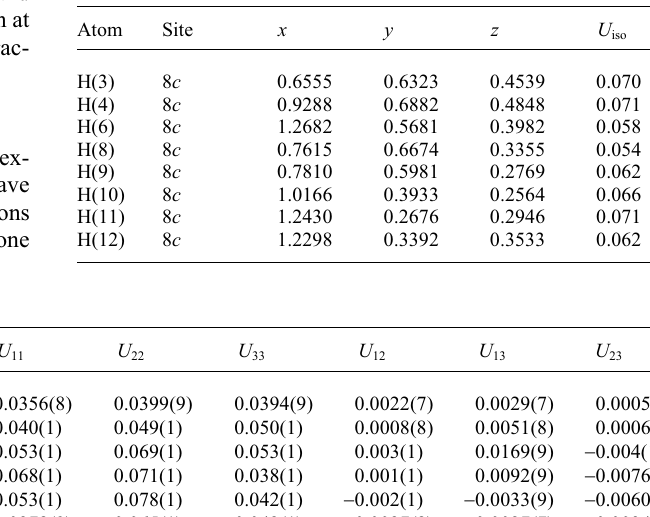
Table 2. Atomic coordinates and displacement parameters (in Å 2 ) .